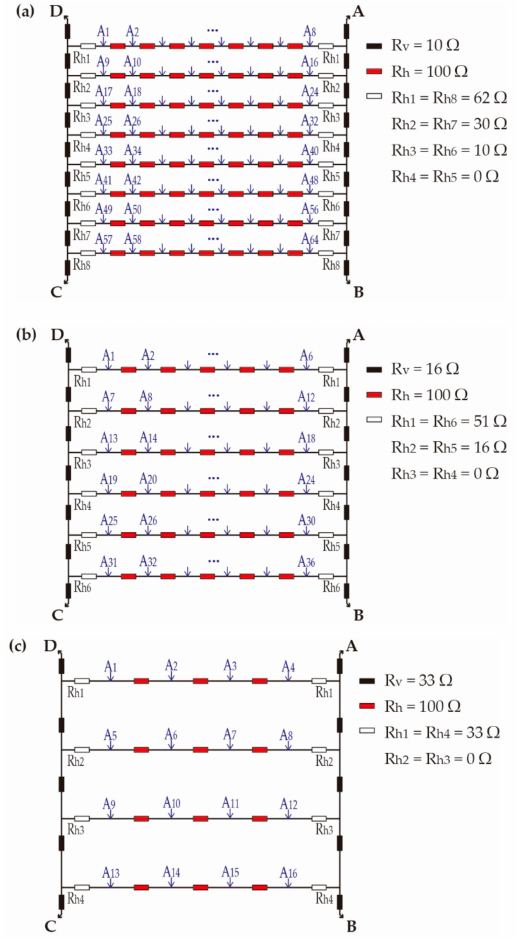
Figure 2. DPC network for the ( a ) 3 mm array, ( b ) 4 mm array, and ( c ) 6 mm array. The 6 mm array required the smallest number of electronic components, thereby achieving less complex PCB design per unit